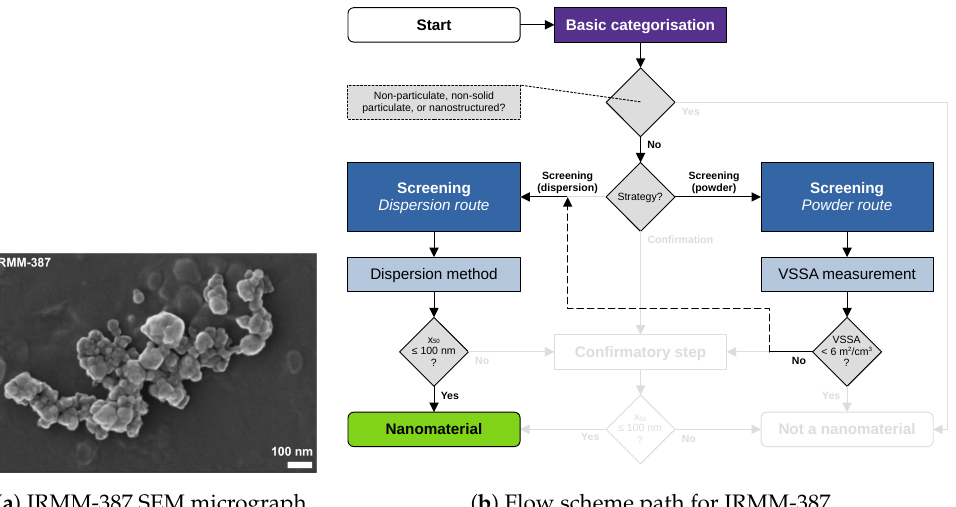
Figure 4. IRMM-387 (BaSO 4 , ultrafine grade): ( a ) representative SEM micrograph, and ( b ) respective flow scheme path. First, the tier 1 method BET yielding a VSSA = 149 m 2 /cm 3 leads to a switch from the powder route to the dispersion route. Then, the tier 1 method DLS yielding an x 50 = 76 nm leads to a “nanomaterial” categorisation.